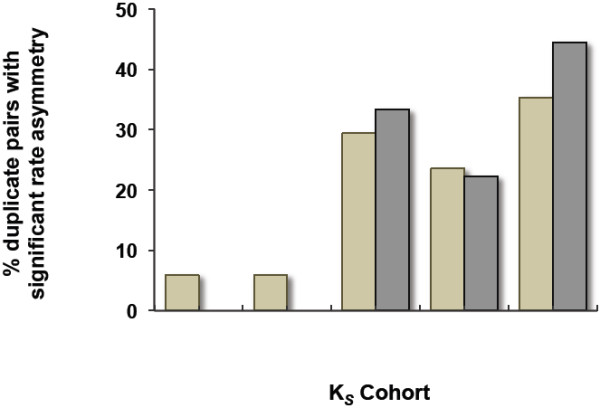
Percent C. elegans gene duplicate pairs displaying significant nucleotide (beige) and amino acid (grey) rate asymmetry by Tajima’s relative rate test within each of five KS cohorts. Age cohorts 0 ≤ KS < 0.01, 0.01 ≤ KS < 0.03, 0.03 ≤ KS < 0.05, 0.05 ≤ KS < 0.08, and 0.08 ≤ KS < 0.14 are represented by 24, 29, 29, 32, and 16 duplicate pairs, respectively.